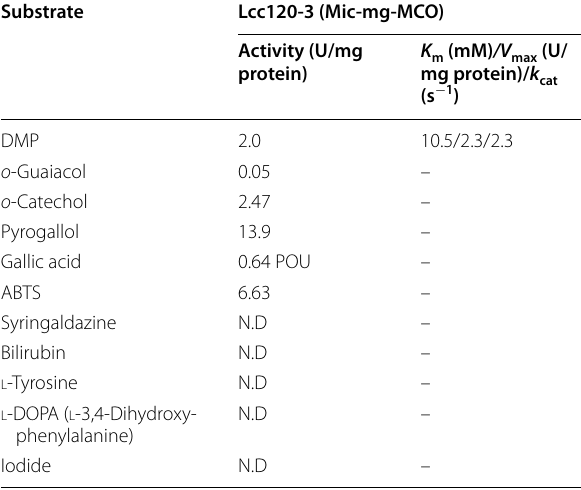
Table 4 Substrate specificity and kinetic parameters of